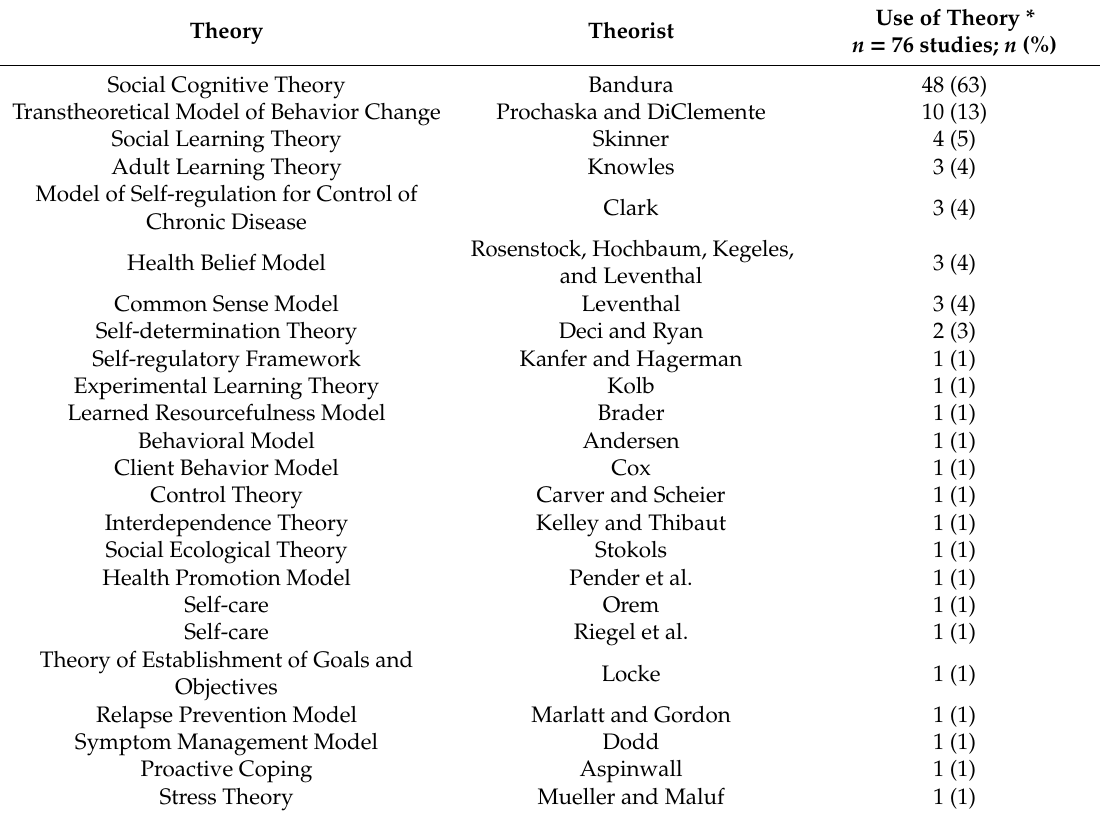
Table 2. Theories used in self-care